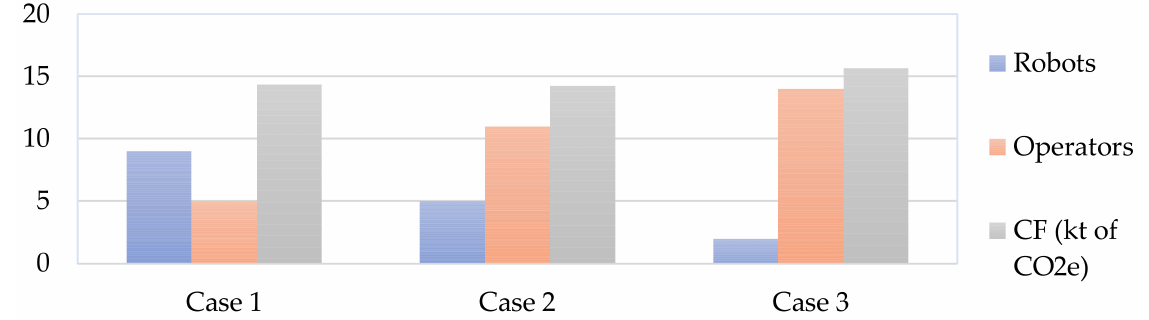
Figure 9. CF generated during the product-manufacturing process for every scenario/case